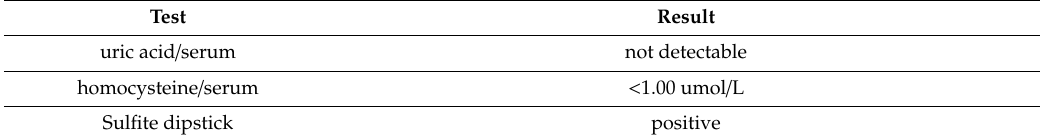
Table 1. Abnormal results of laboratory and imagine assessment of our Proband.